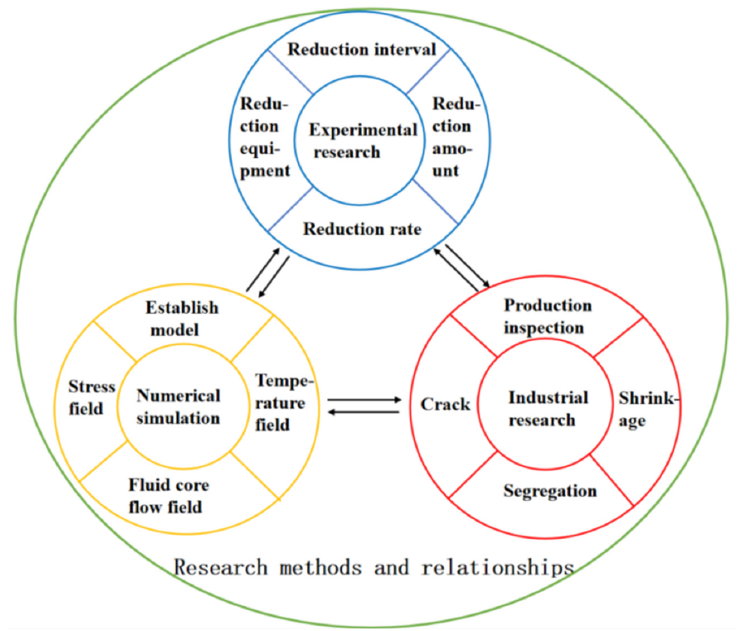
Figure 3. Classification of research methods.